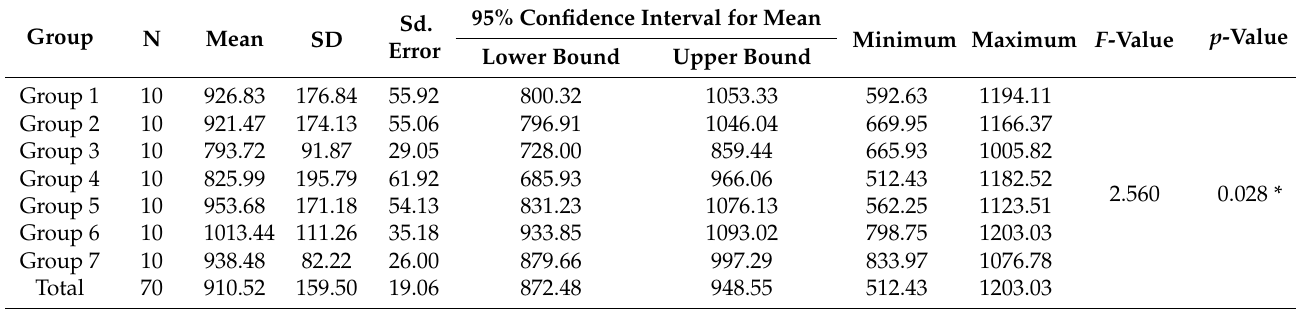
Table 4. Intergroup comparison of mean maximum compressive load (N) assessed using the posthoc Bonferroni test. Group 1 Group Group Table 3. One-way ANOVA for mean maximum load (N).